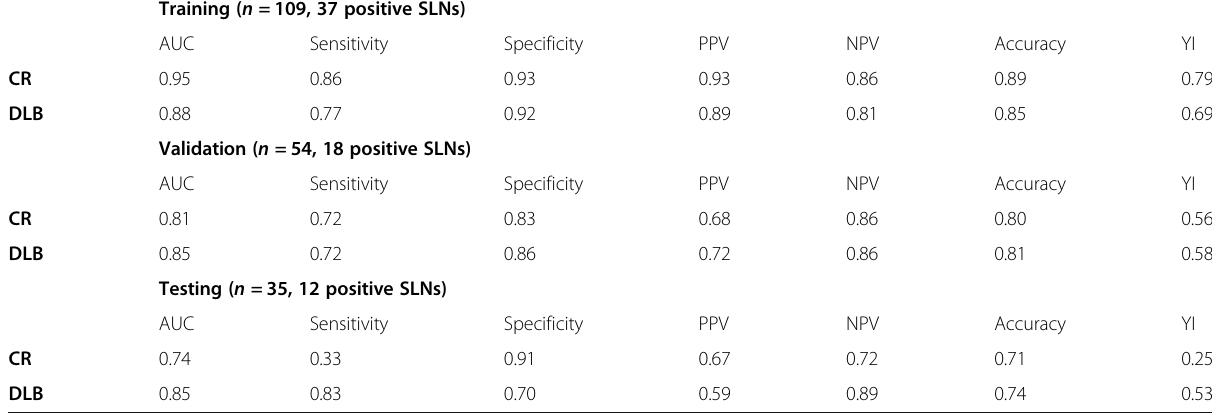
Table 4 Predictive performance results for intratumoral region for CR and DLB models. Values shown are from the random seed with highest training set accuracy. The DLB model performed similarly to CR in the validation set. In the testing set, DLB model outperformed CR model in numerous metrics, including NPV, accuracy, and YI. This indicates the DLB model might be more generalizable and less sensitive to pixel size